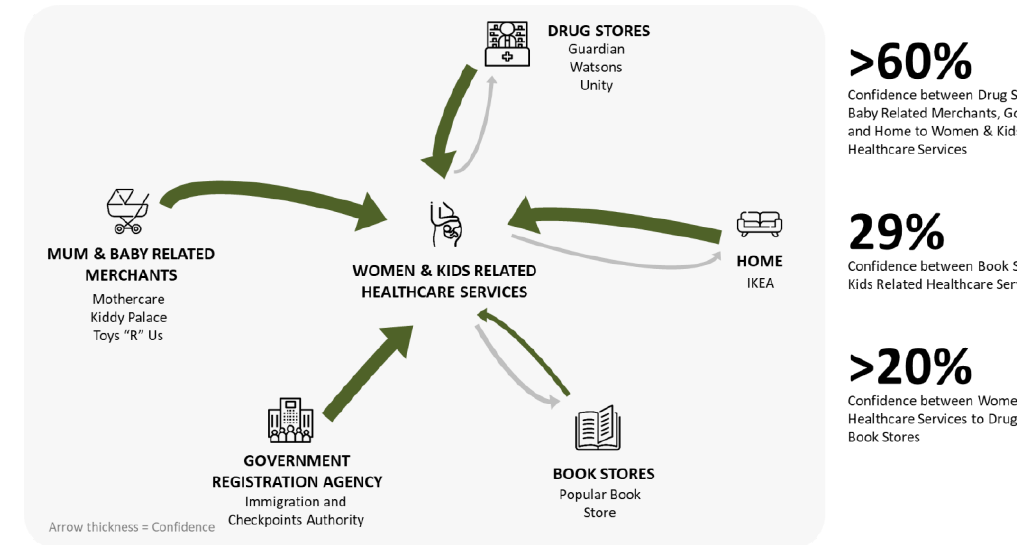
Figure 15. Merchant association rules for ‘ Women and Kids ’ customers.